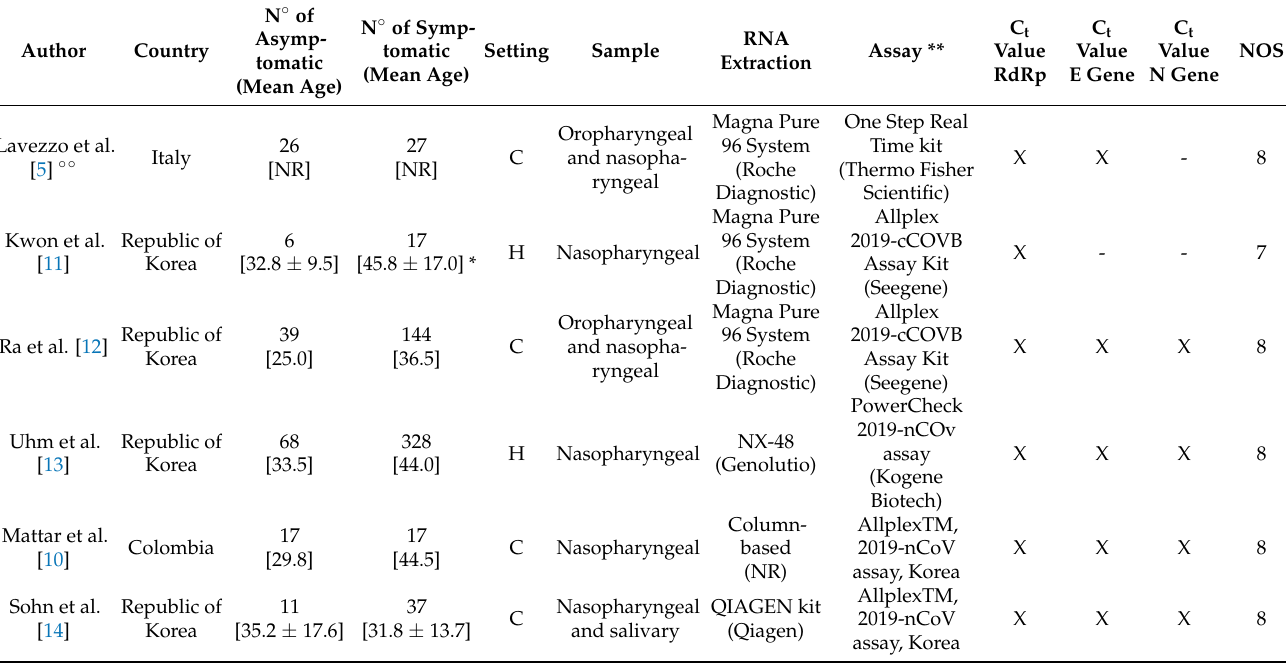
Table 1. General characteristics of the studies